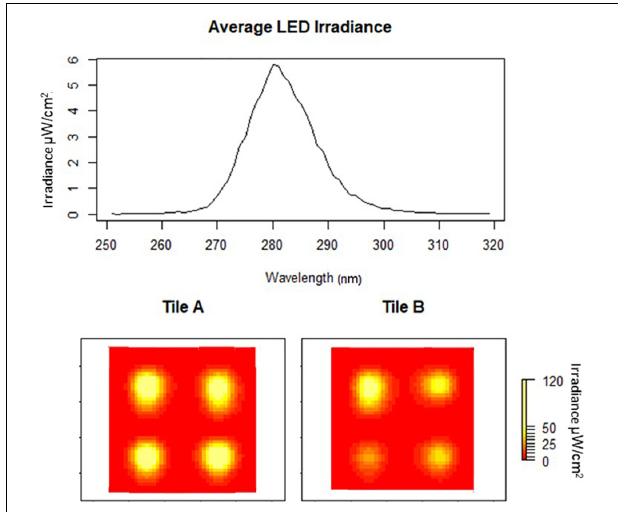
FIGURE 2 | Average peak wavelength of eight LEDs embedded in two tiles at 24 volts (A,B) . Heat maps of individual tile irradiances (yellow high and red